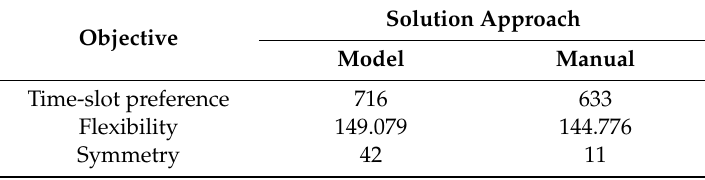
Table 2. Improvements in the three objectives were observed with the model